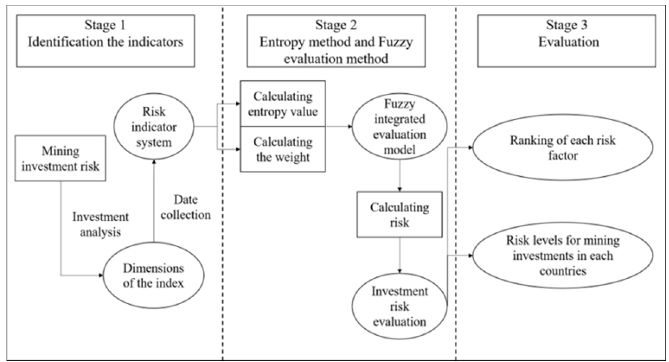
Figure 1. Evaluation procedure.